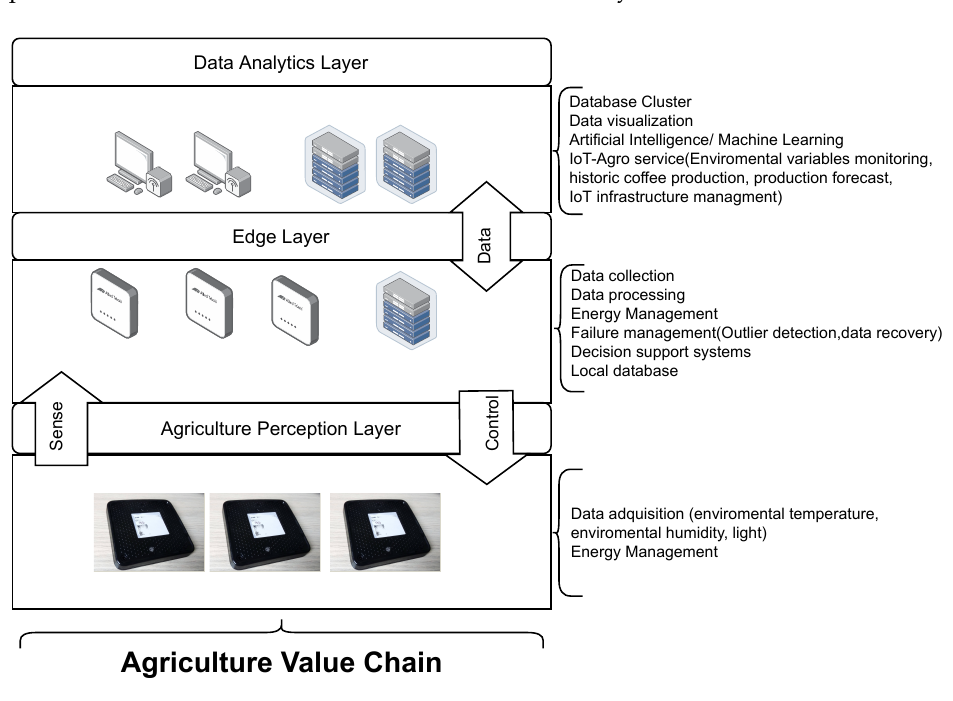
Figure 2. Smart Farming System